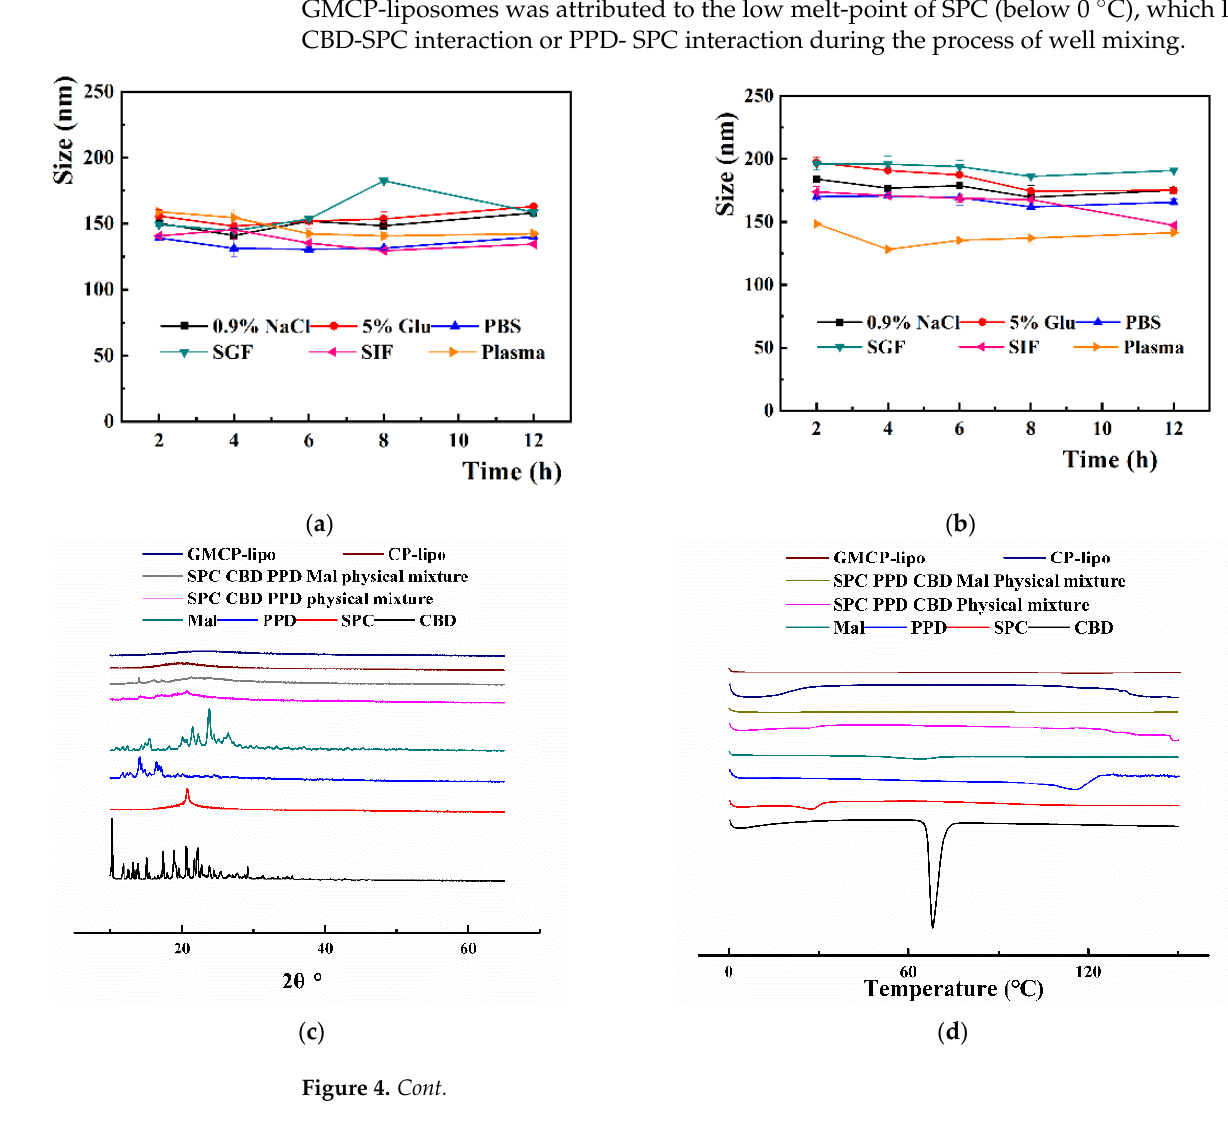
( f ) Figure 4. The particle size change of CP-liposome ( a ) and GMCP-liposome ( b ) in various physical media at 37 °C, and the XRD ( c ) and DSC ( d ) pattern of lyophilized CP-liposome and GMCP-lipo- some in contrast to free CBD, free PPD, SPC, Mal, and the corresponding physical mixture. The accumulative in vitro CBD release from CP-liposomes and GMCP liposomes within 144 h ( e ) or within 24 h ( f ). 3.3. X-ray Diffraction Investigation and Differential Scanning Calorimetry It was clear from the XRD patterns (Figure 4c) that free CBD, PPD and Mal all dis- played sharp diffraction peaks, indicating their existence in a crystalline form. However, no diffraction peak was observed in lyophilized CP-liposomes, and GMCP-liposomes, in- dicating the absence of CBD or PPD crystalline in the resultant liposomes. The very weak CBD or PPD diffraction peaks in the physical mixture corresponding to CP-liposomes and GMCP-liposomes was attributed to the low melt-point of SPC (below 0 °C), which led to CBD-SPC interaction or PPD- SPC interaction during the process of well mixing. A similar phenomena also occurred in the DSC pattern (Figure 4d), where CBD dis- played a sharp peak at 68.03 °C; corresponding to its melting point of CBD, PPD displayed a weak peak and these two peaks totally displayed in lyophilized CP-liposomes and GMCP-liposomes, demonstrating that there was an interaction between both CBD-excip- ients and PPD-excipients.